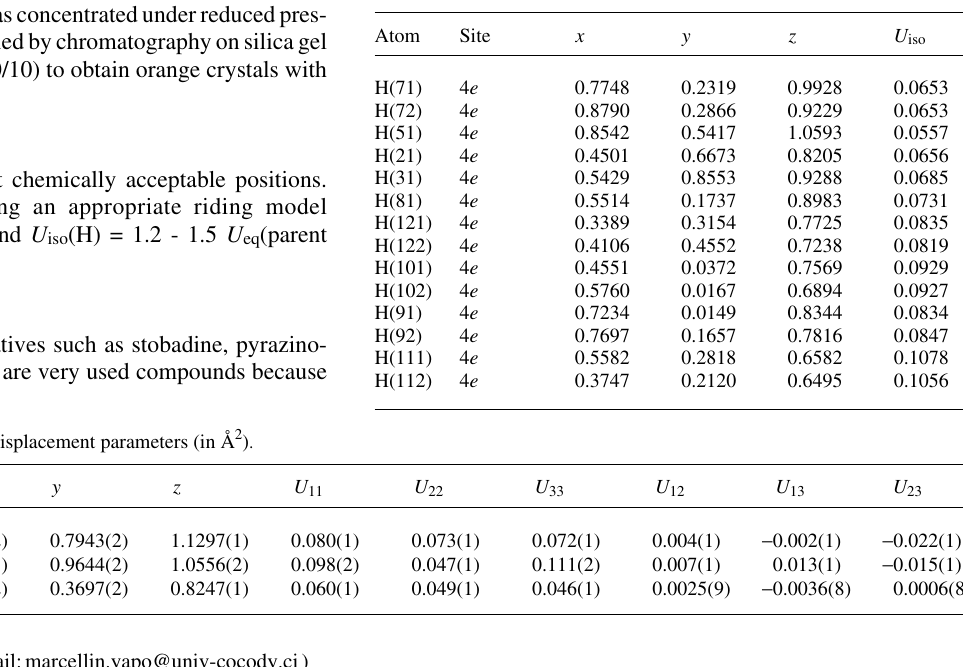
Table 2. Atomic coordinates and displacement parameters (in Å 2 ) .